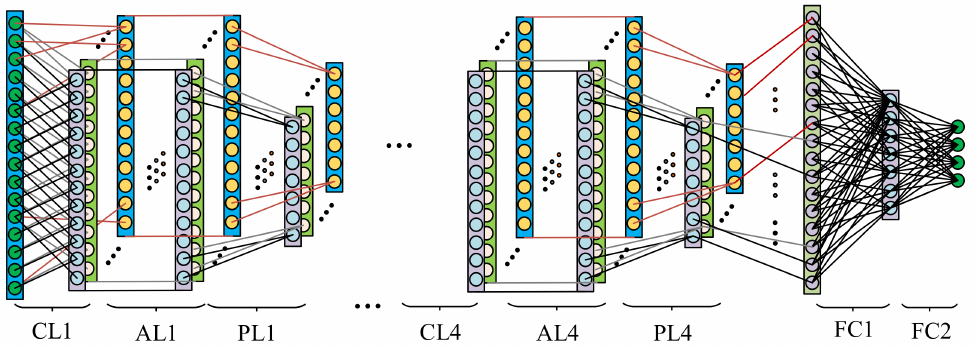
Figure 4. The improved one-dimensional convolutional neural